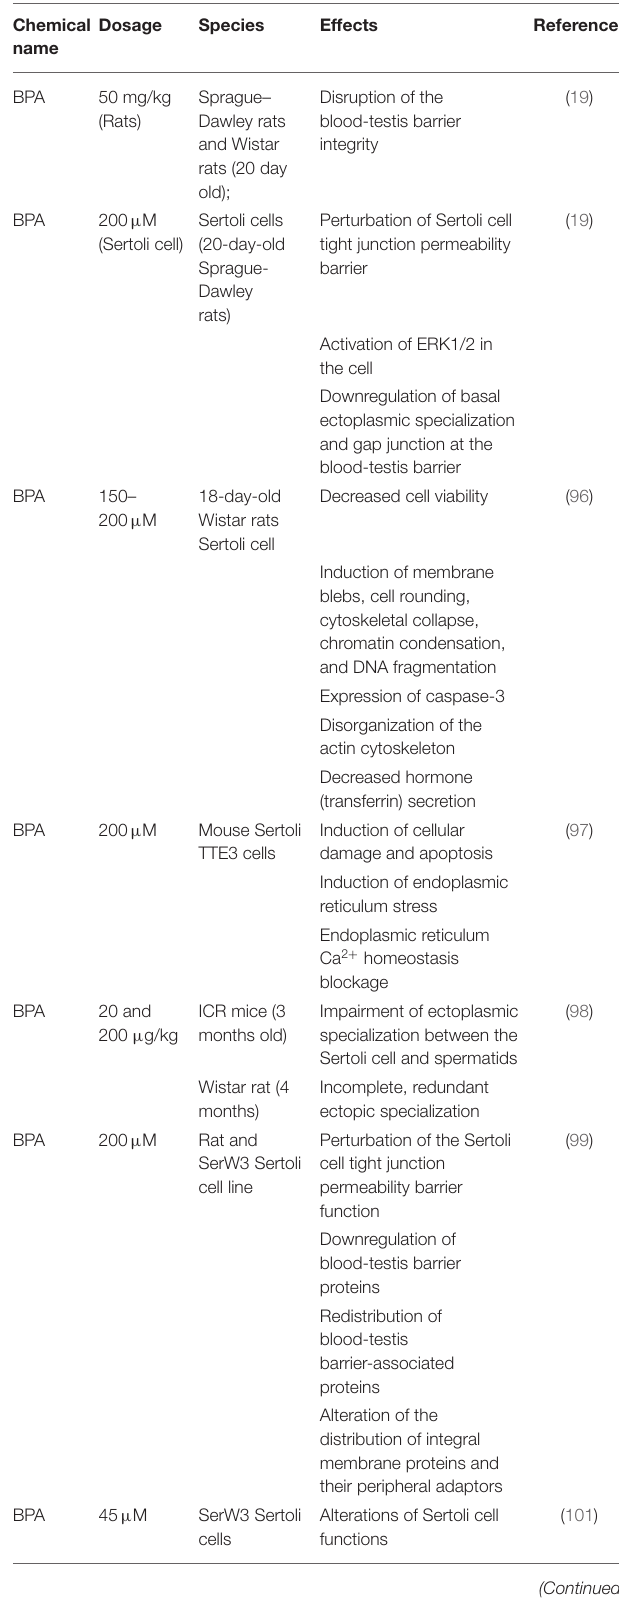
TABLE 2 | Effects of bisphenols on Sertoli